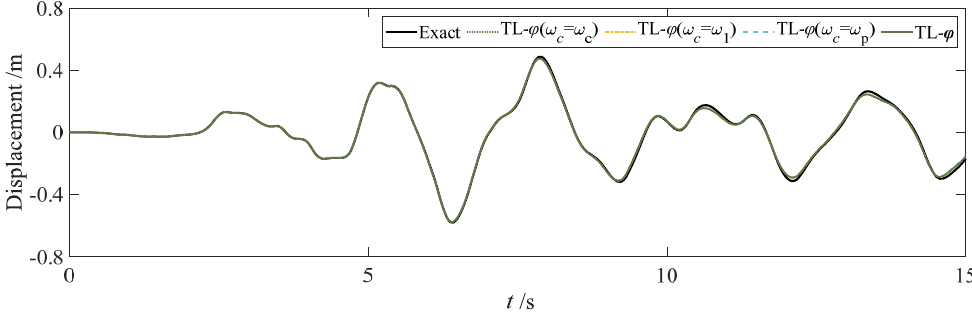
Figure 15. Displacement responses of the 4th